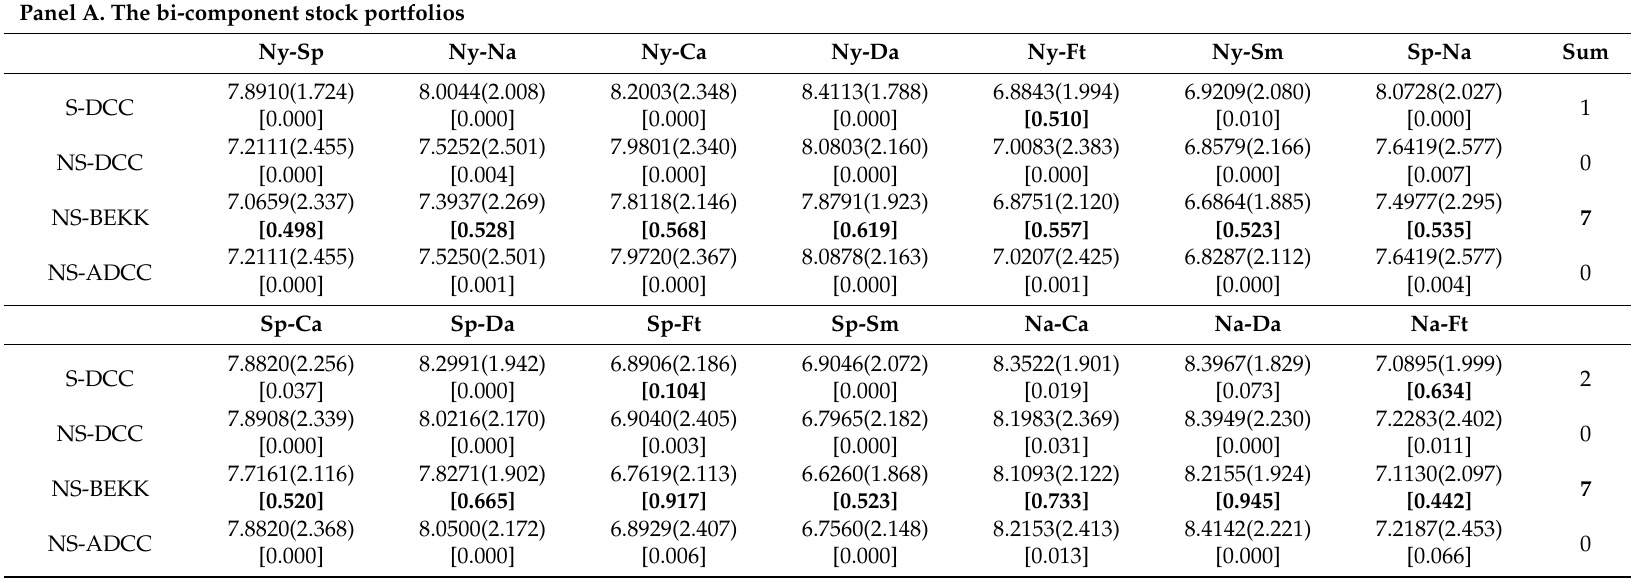
Table 11. The efficiency evaluation test based on the market risk capital for equal weight stock and currency-stock portfolios. Panel A. The bi-component stock